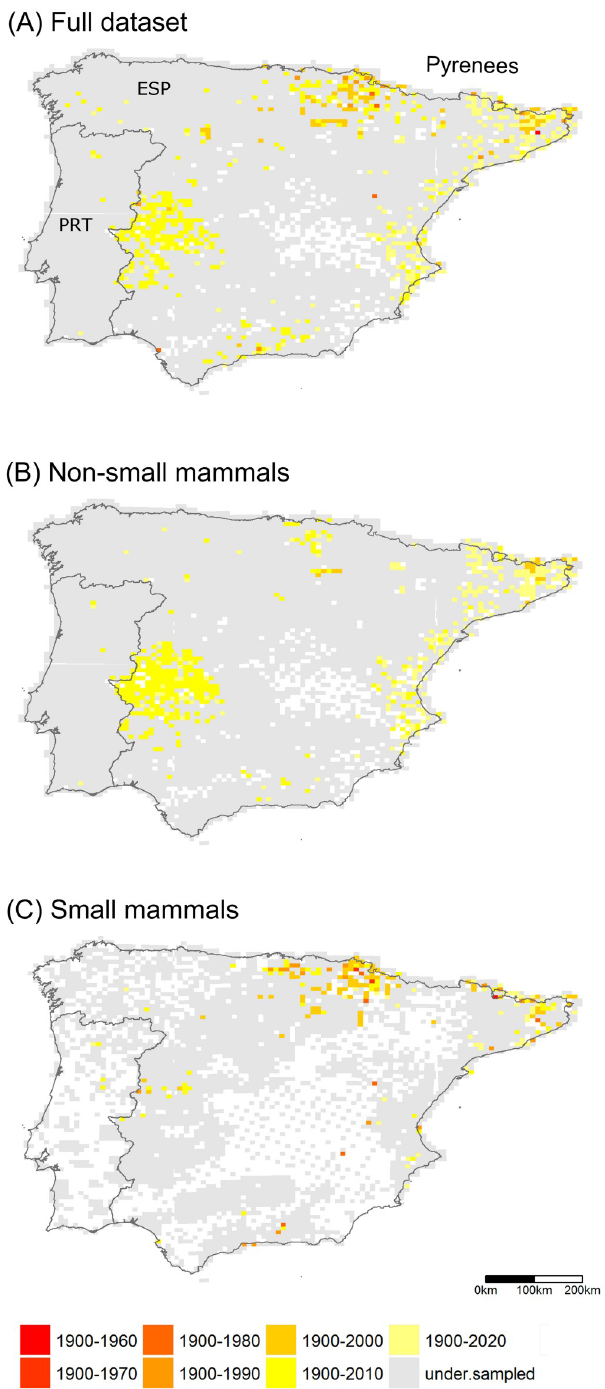
Fig 5. Recency maps of well-sampled cells (number of records � 25 and C c � 0.7) across the Iberian Peninsula (PRT: Portugal, ESP: Spain) for the (a) full dataset and (b) non-small mammals (Lagomorpha, Artiodactyla, Carnivora, Chiroptera and Erinaceidae) and (c) small mammals (Rodentia and Soricidae) datasets. Yellow colors indicate cells that reached inventory completeness in recent decades. White cells have no data.